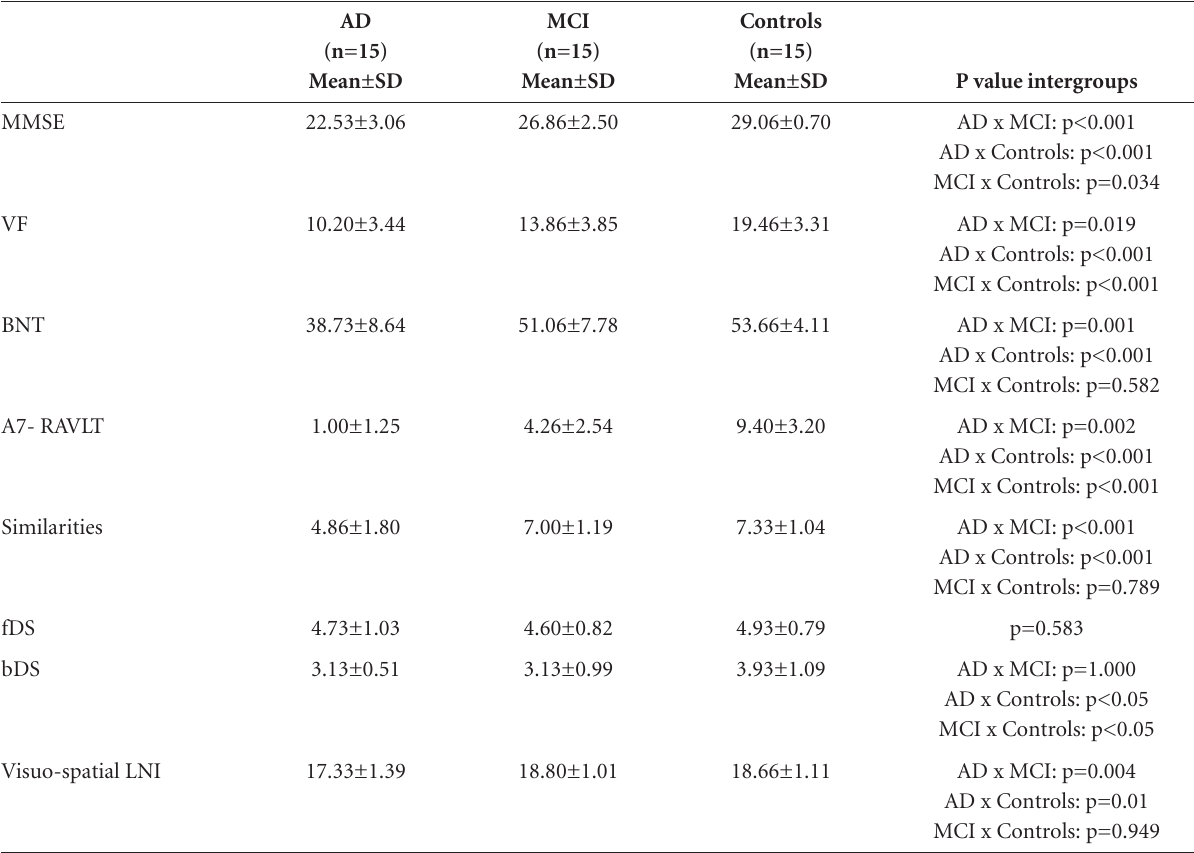
Table 2. Neuropsychological results of amnestic mild cognitive Impairment (AMCI), Alzheimer disease (AD), and normal control